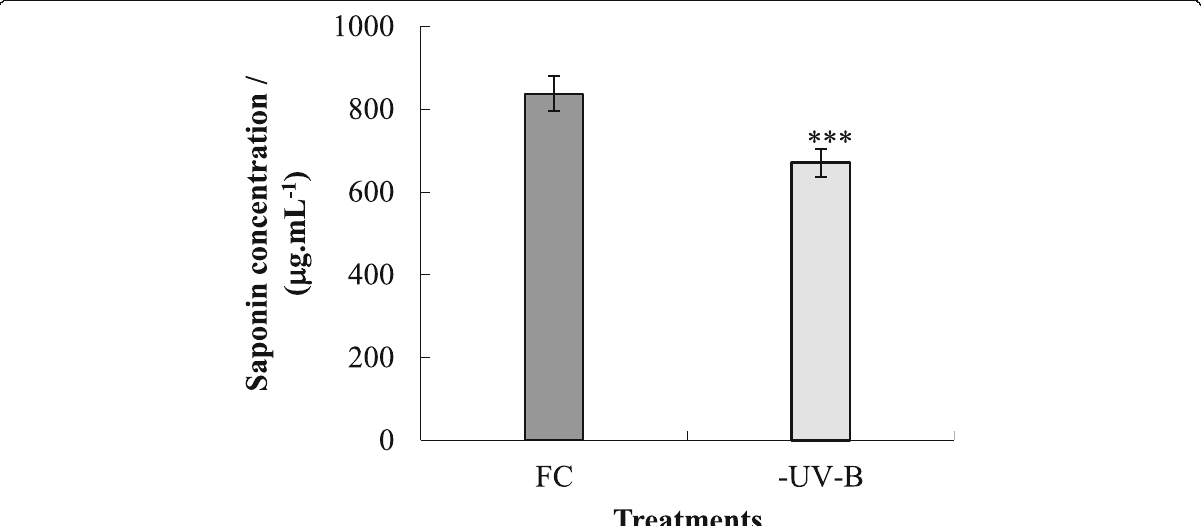
Fig. 4 Saponin content in leaves of cotton var. Vikram grown in filter control (FC) and UV-B excluded conditions. The vertical bar indicates ±SE for mean. Values are significantly different at ** P <0.01 from filter